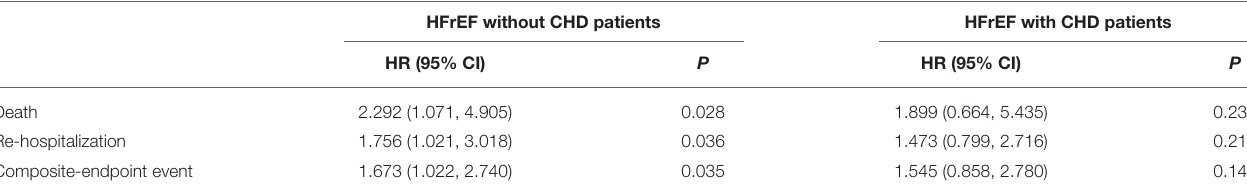
FIGURE 5 | Kaplan–Meier survival curves according to baseline plasma Gal-3 levels in non-CHD subjects. (A) Death rates according to higher of lower baseline plasma Gal-3 levels. (B) Re-hospitalization rates according to higher of lower baseline plasma Gal-3 levels. (C) Composite-endpoint event rates according to higher of lower baseline plasma Gal-3 levels. Gal-3, Galectin-3. TABLE 4 | Predictive value of baseline plasma Gal-3 to long-term outcomes in HFrEF with or without CHD